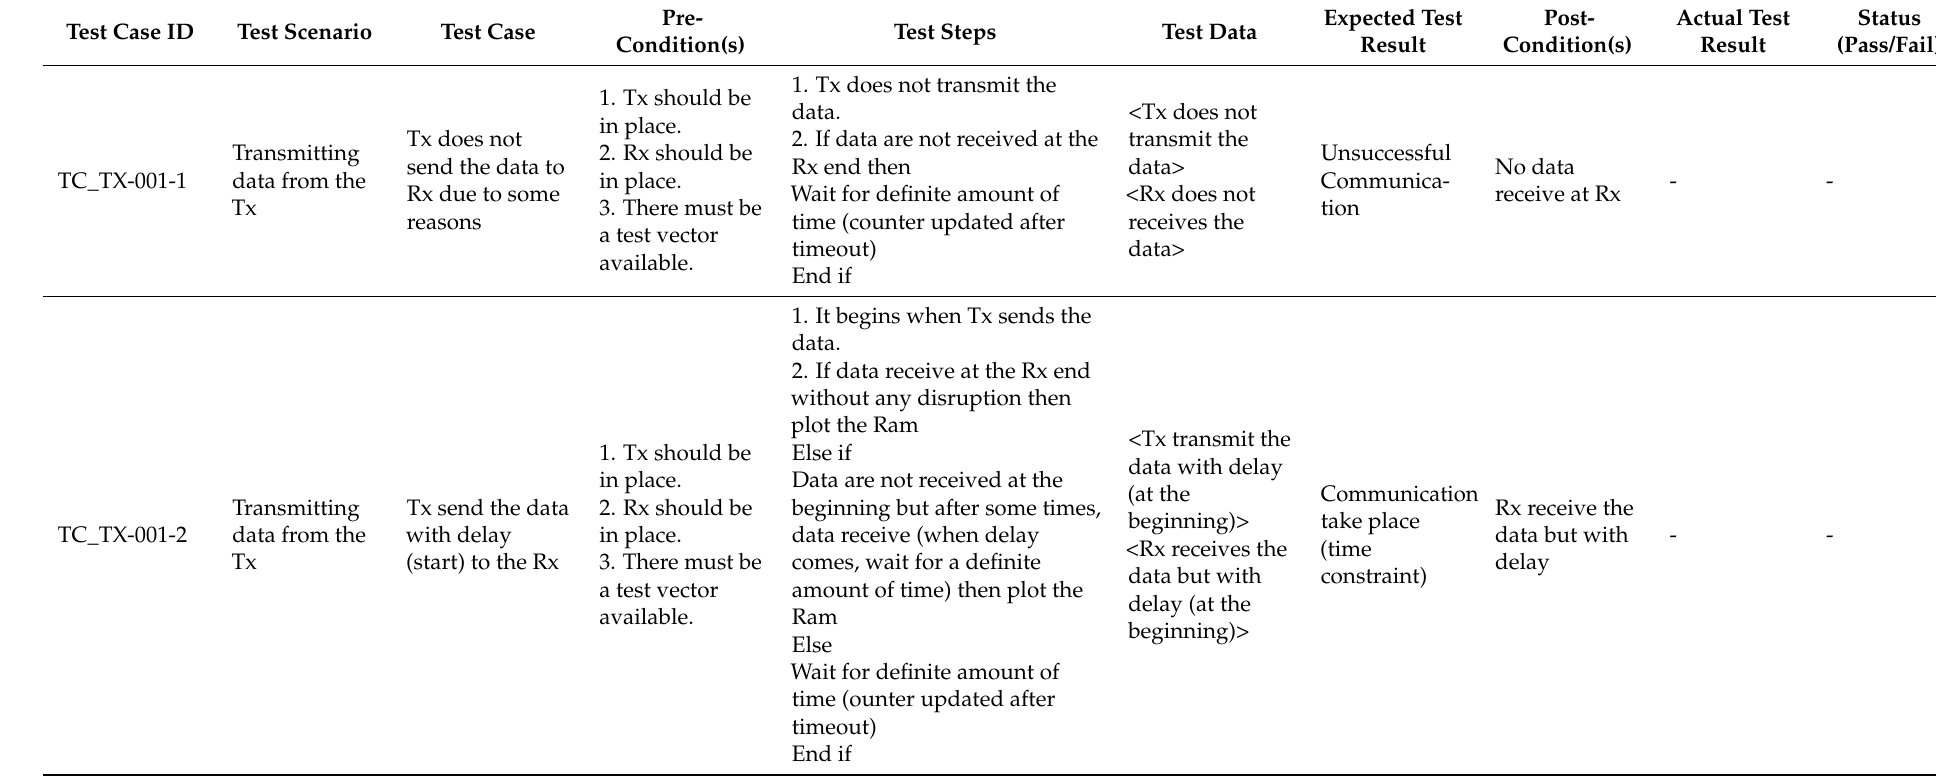
Table 4. Test cases for